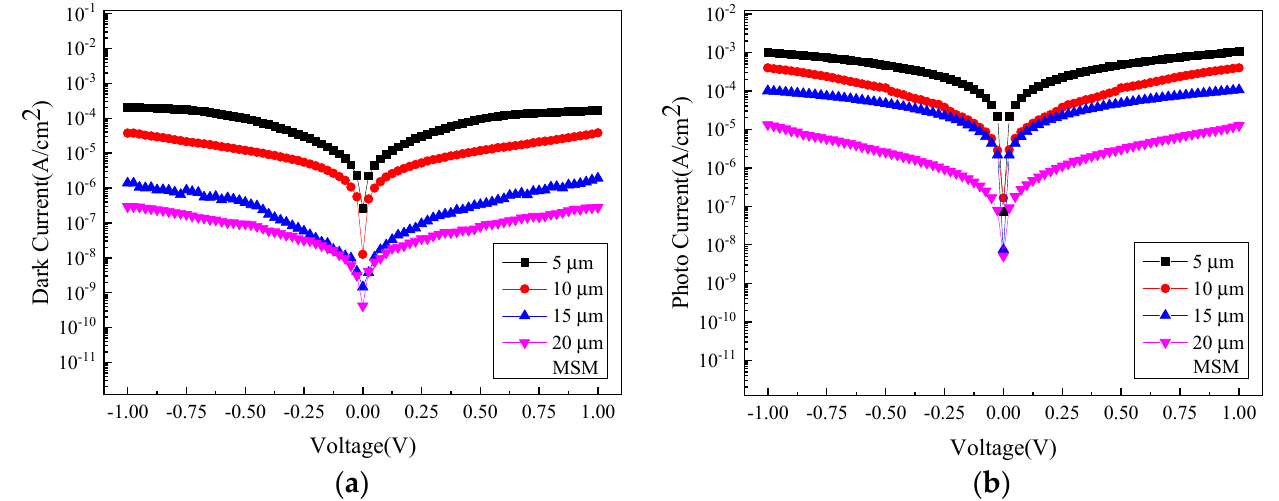
Figure 3. The current density–voltage relations for the MSM photodetectors with four different sizes: ( a ) under no illumination, and ( b ) under the illumination of 2000 nm wavelength. By ranking the magnitude of the current from the highest to the lowest, the smallest electrode size of 5 µ m yields the highest current while the largest size of 20 µ m has the lowest current. This observation is attributed to the fact that as the distance between the interdigital electrode spacing increases, the electron-hole pairs (EHPs) distancing away from the respective electrodes also increase, thereby augmenting the resistance they encounter